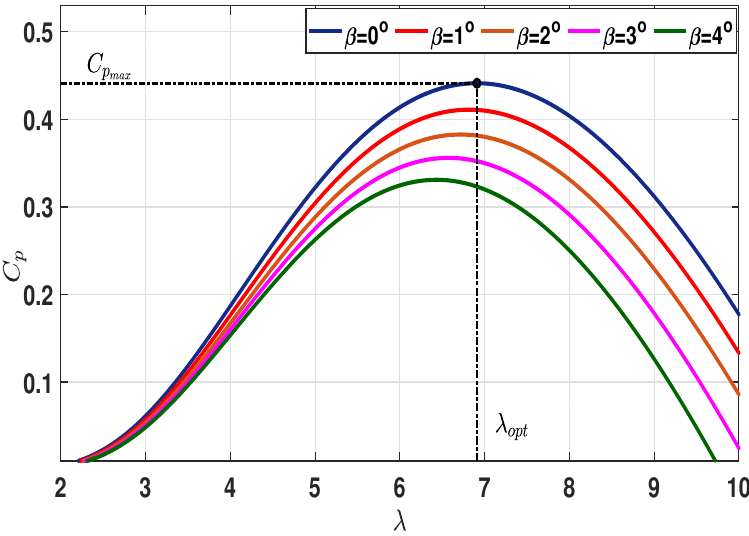
Figure 1. λ − C p relationship of a typical WECS for varying pitch angle β